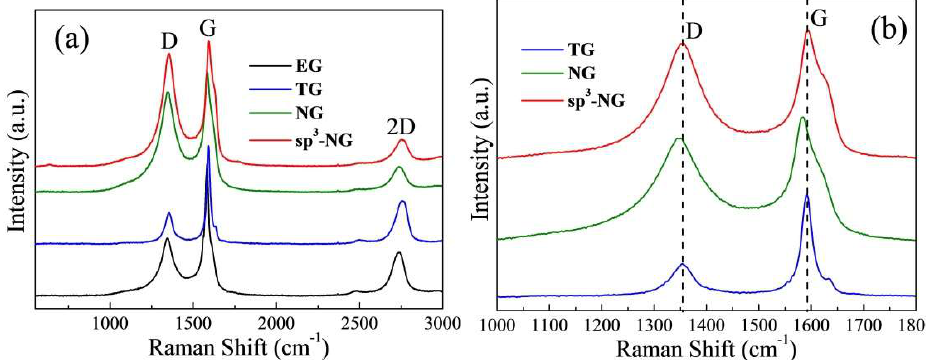
Figure 2. ( a ) Raman spectra of EG, TG, NG, and sp 3 -NG; ( b ) The D and G peaks of TG, NG, and sp 3 -NG. Table 1. The ratios of different types of N and elemental contents of the typical samples. Samples (at %) Pyridinic-N Pyrrolic-N Graphite-N Amino-N